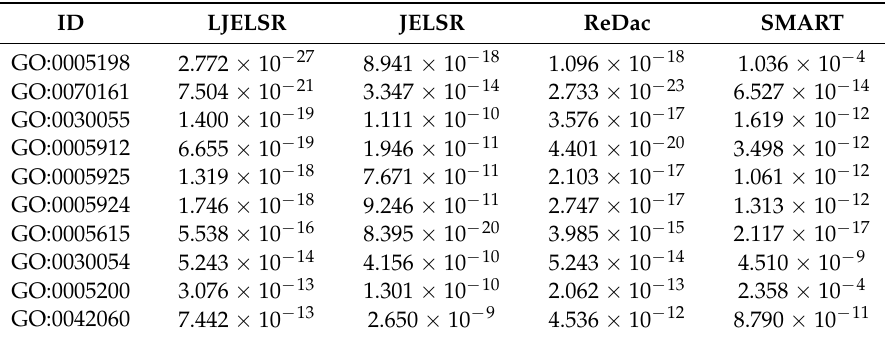
Table 6. The p -values of different methods for the ESCA dataset.